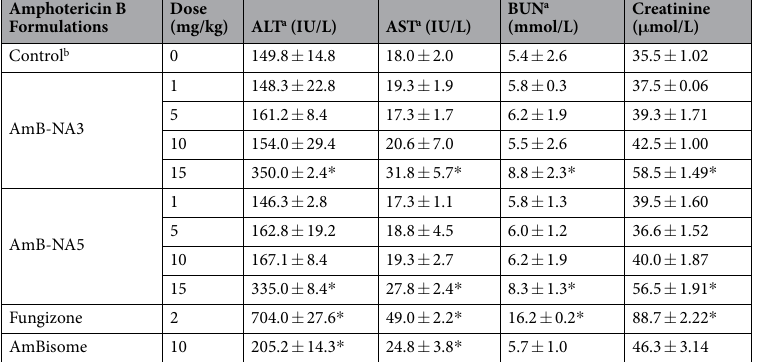
Table 3. Effect of amphotericin B formulations on hepatic and renal parameters. The two commercial formulations of Amphotericin B, Fungizone and AmBisome, were used at dose of 2 and 10 mg/kg, respectively. The new formulations (AmB-NA3 and AmB-NA5) were used in a range of concentrations (1–15 mg/kg). Values are mean ± SD. * Significant at P < 0.05compared with the results for the respective control mice, Student’s t test. a ALT, alanine aminotransferase; AST, aspartate aminotransferase; BUN, blood urea nitrogen. b Control mice were given only